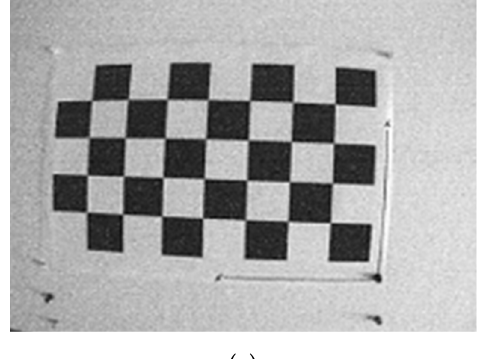
Figure 4. ( a ) A distorted image of a checkerboard pattern from a multispectral camera and ( b ) extrinsic parameters action visualisation. Images were taken from different angles and distances to calculate extrinsic parameters and minimise radial barrel distortion.